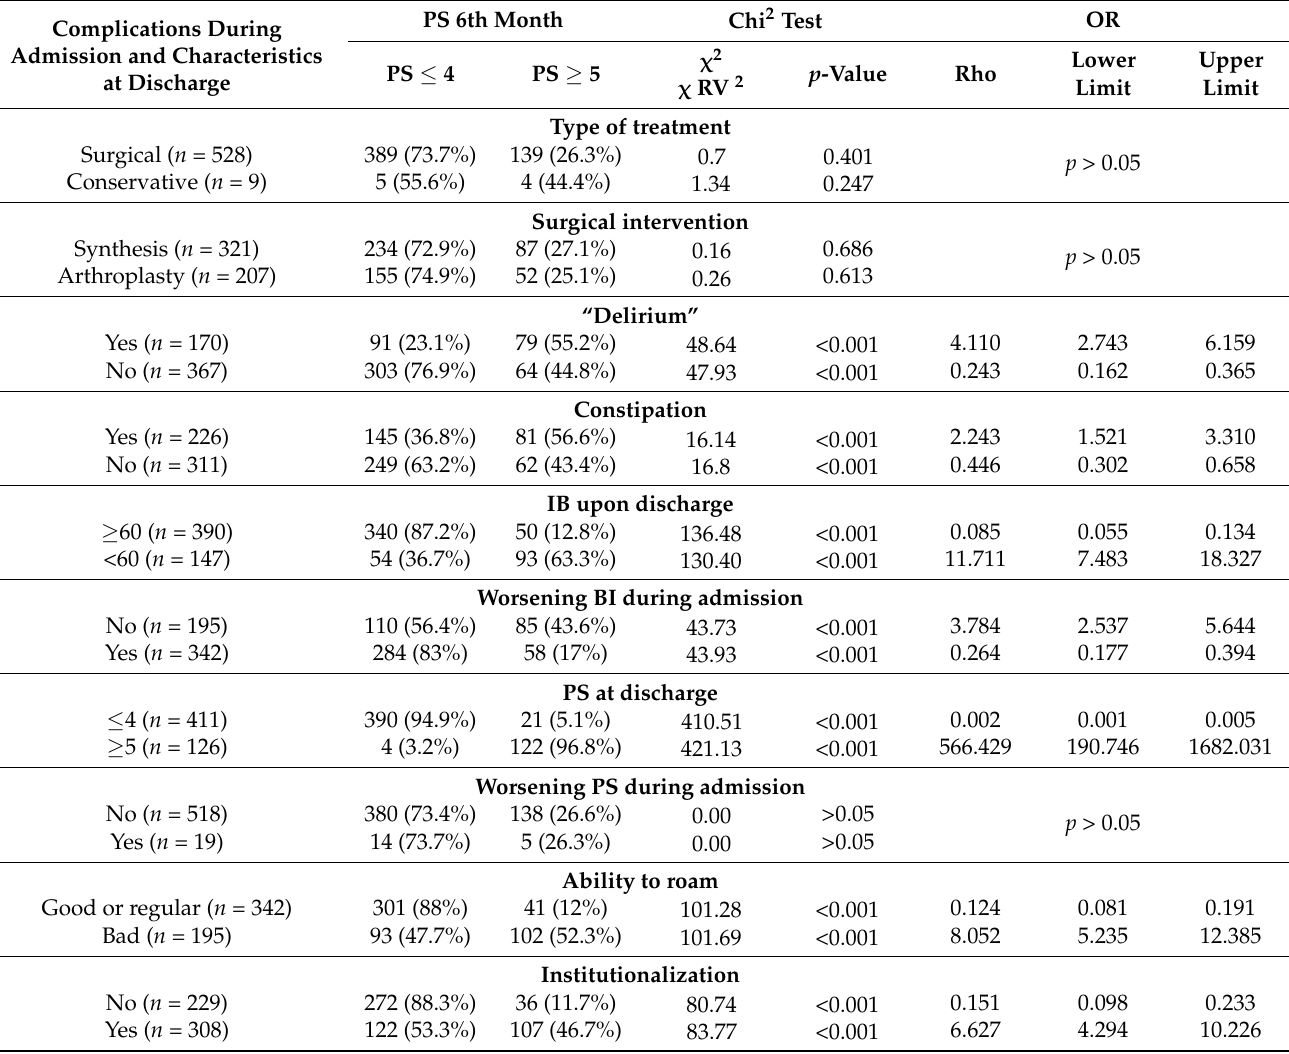
Table 3. Results of the Chi 2 test among complications and characteristics at discharge and their relationship with cognitive impairment at the sixth